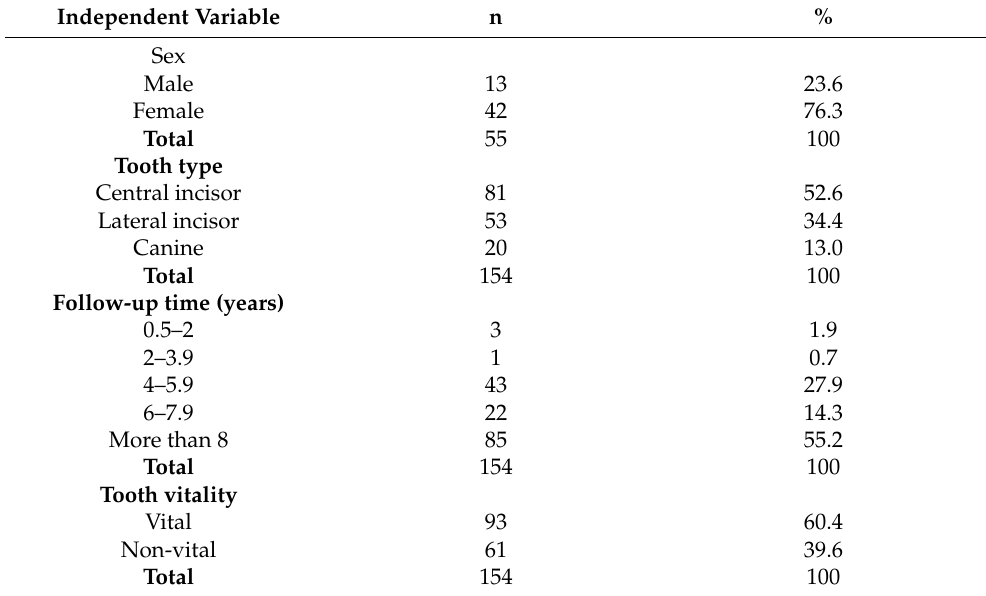
Table 1. Distribution of porcelain veneer